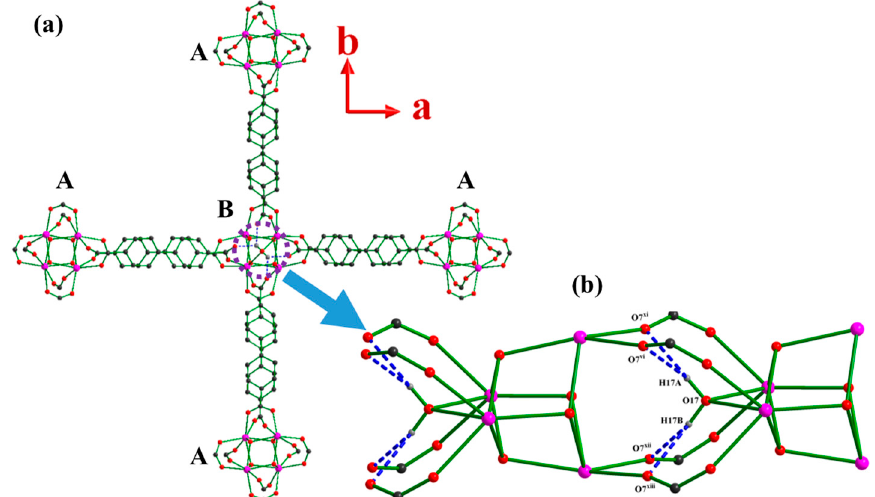
Figure 6. ( a ) The Y1-containing {Y 4 O 4 } core (B) involved in the O-H ⋯ O hydrogen bond in 1 ; ( b ) The enlarged O17-H17A ⋯ O vi , O17-H17B ⋯ O xii and their symmetry imposed hydrogen bonds interactions in the Y1-containing {Y 4 O 4 } core (B) in 1 (Dash lines represent O-H ⋯ O hydrogen bonds, symmetry codes see in the Table S3 from Supplementary Materials).